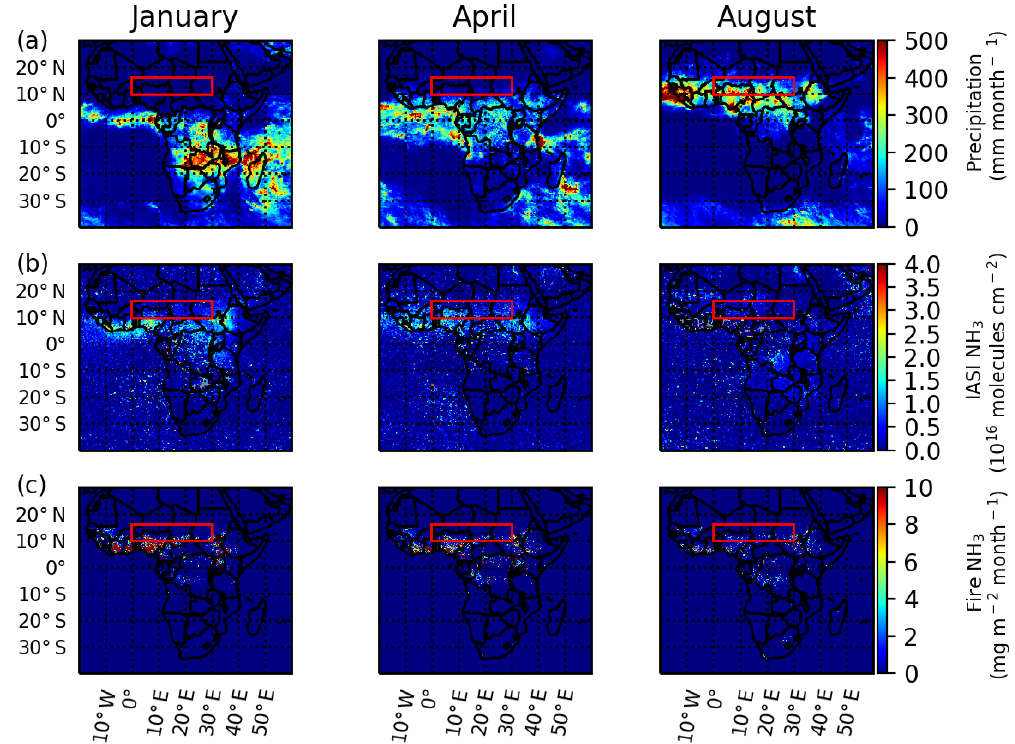
Figure 1. Seasonality of precipitation and NH 3 emissions in Africa during 2008. Monthly TRMM precipitation (a) , IASI-NH 3 concentra- tions (b) , and GFED4s NH 3 emissions (c) over Africa in January, April, and August